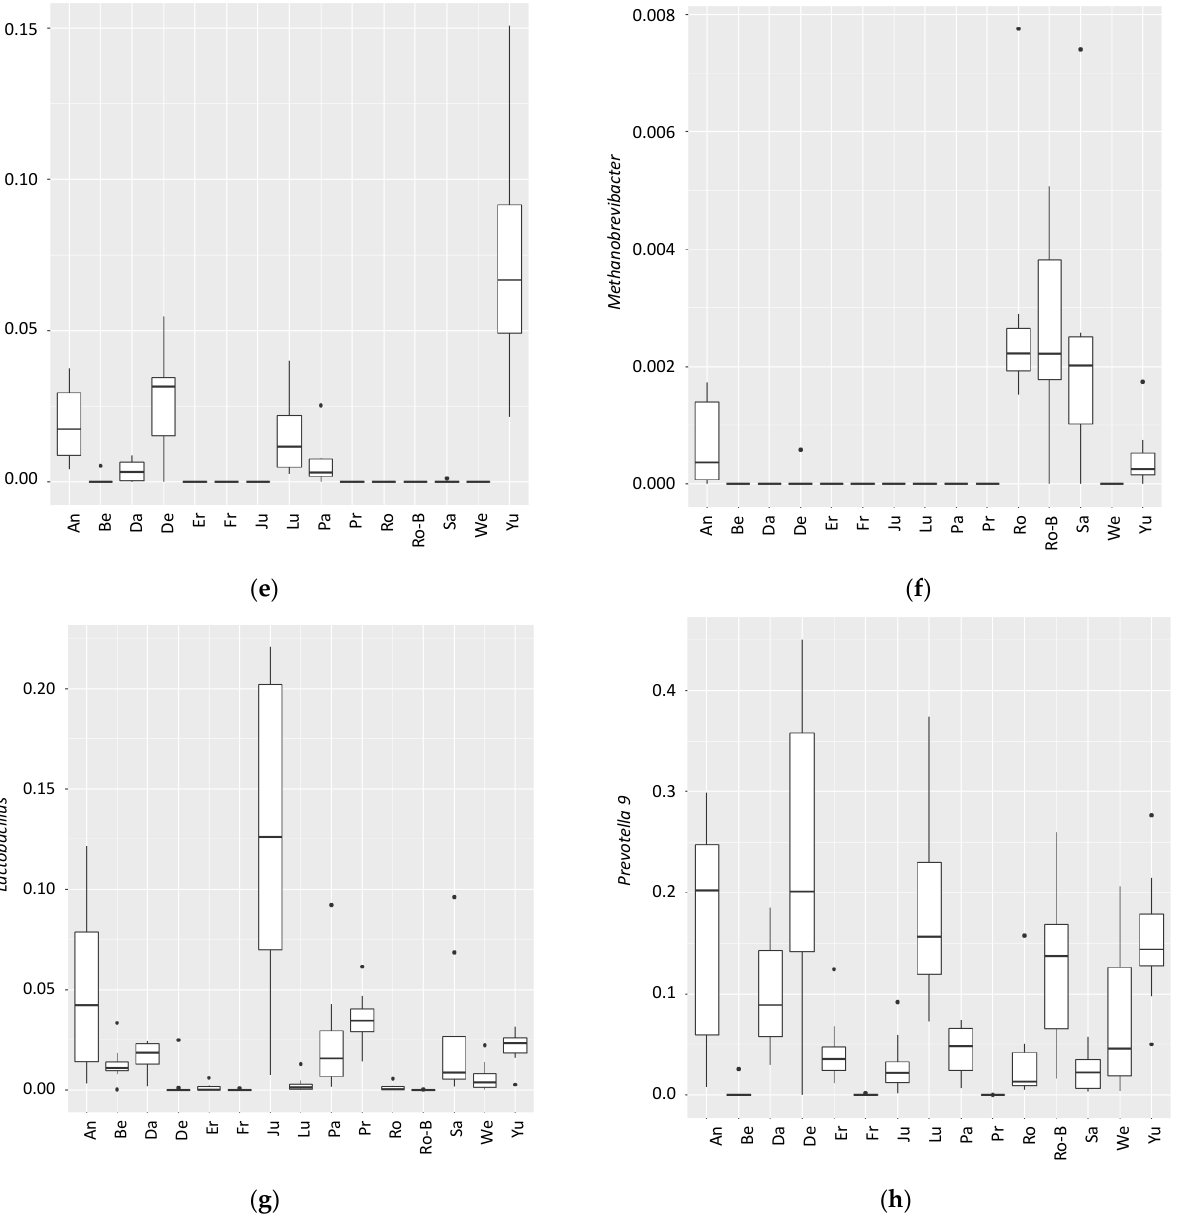
Figure 3. Differences in several taxa between individuals indicating the high interindividual variation in gut microbiota composition. Lachnospiraceae NK3A20 group (( a ); q -value = 6.9 × 10 − 17 ); Holdemanella (( b ); q -value = 4.6 × 10 − 14 ); Faecalicoccus (( c ); q -value = 5.5 × 10 − 14 ); Slackia (( d ); q -value = 7.4 × 10 − 14 ); Alloprevotella (( e ); q -value = 8.3 × 10 − 14 ); Methanobrevibacter (( f ); q -value = 7.6 × 10 − 12 ); Lactobacillus (( g ); q -value = 2.2 × 10 − 11 ); Prevotella 9 (( h ); q -value = 1.8 × 10 − 10 It is well-known and has recently been confirmed that the gut microbiota is highly individual-specific [32]. This interindividual difference may also be the reason why a di- etary intervention may show an effect or not [33]. We studied the differences in β -diversity between individuals (Figure 4a) in more detail and, when studying the first two principal coordinate axes, we observed that the differences in β -diversity between the samples were either large (usually the consequence of a single intervention; Figure 4b) or very small (Figure 4c). The latter indicated a resilient gut microbiota that was not easily prone to changes [34].